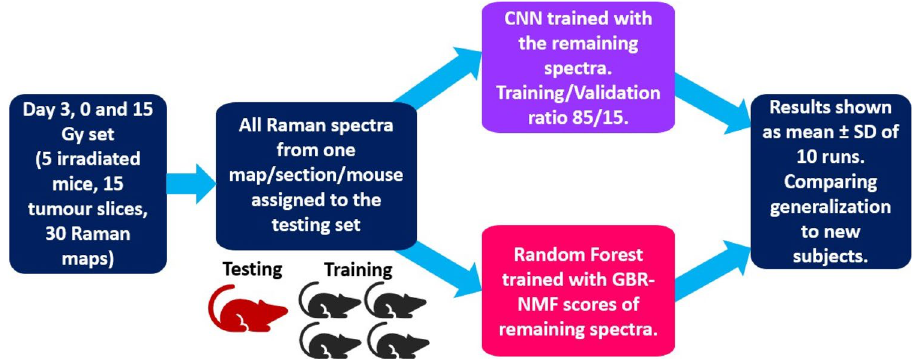
Figure 2. Subject-wise validation training